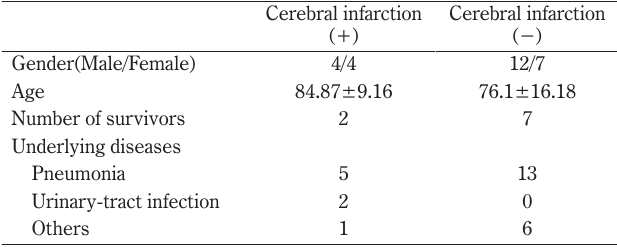
Table 1 Age, gender, and underlying diseases of 27 patients with septic disseminated intravascular coagulation according the occurrence of cerebral